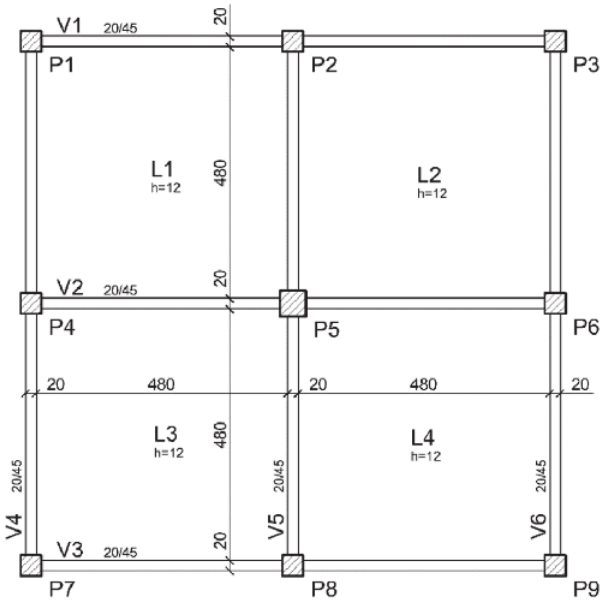
Figure 3 Outline of the typical floor of the idealized